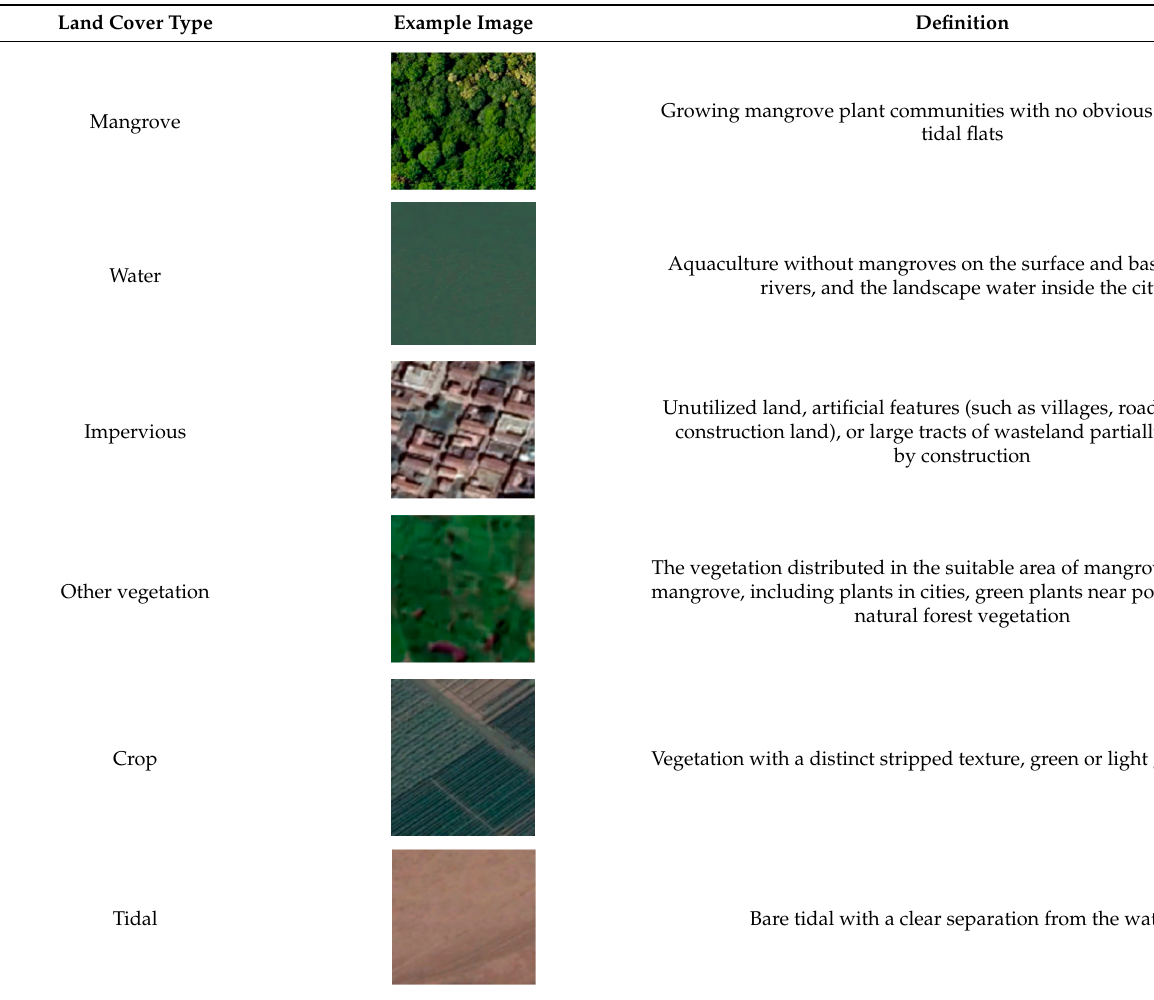
Table 2. Definitions of 6 types of land use in this study.